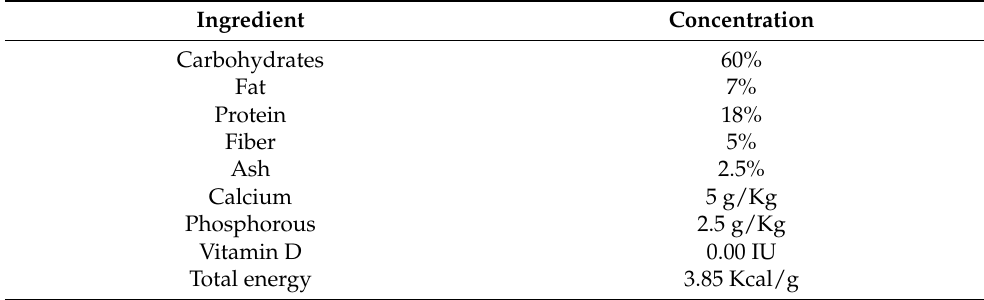
Table 1. Vitamin-D-deficient diet based on AIN-93G composition. Ingredient